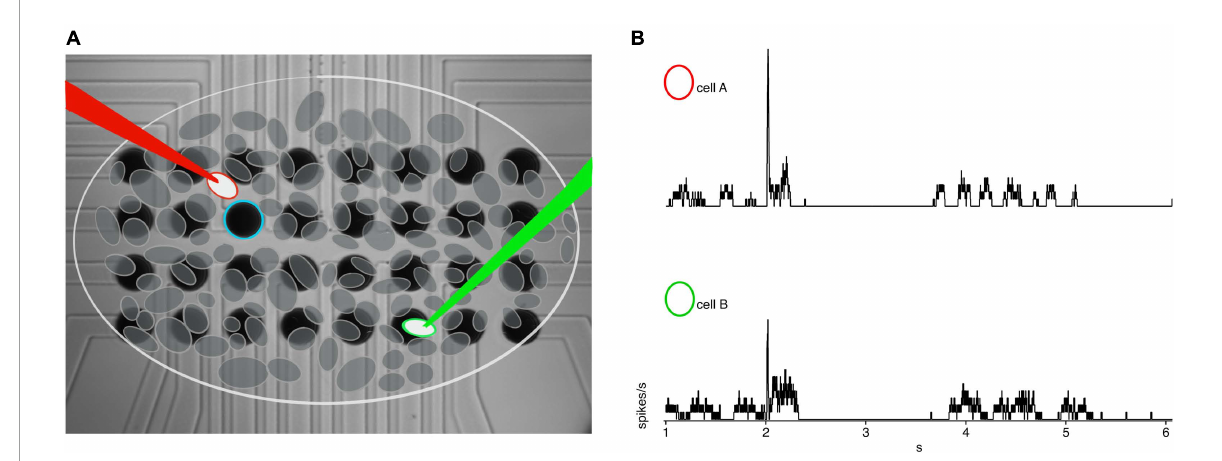
FIGURE1 Example recording set up. (A) 4 × 8 30 µ m iridium oxide electrode grid with schematic representation of RGC’s overlaid. The white circle with red outline indicates the cell of interested closest to the blue stimulating electrode, with a red loose patch recording electrode. The green circle is the secondary cell of interest recorded via the green loose patch electrode. (B) Example rates from cell A (red circle) and cell B (green circle) in rd10 retina.